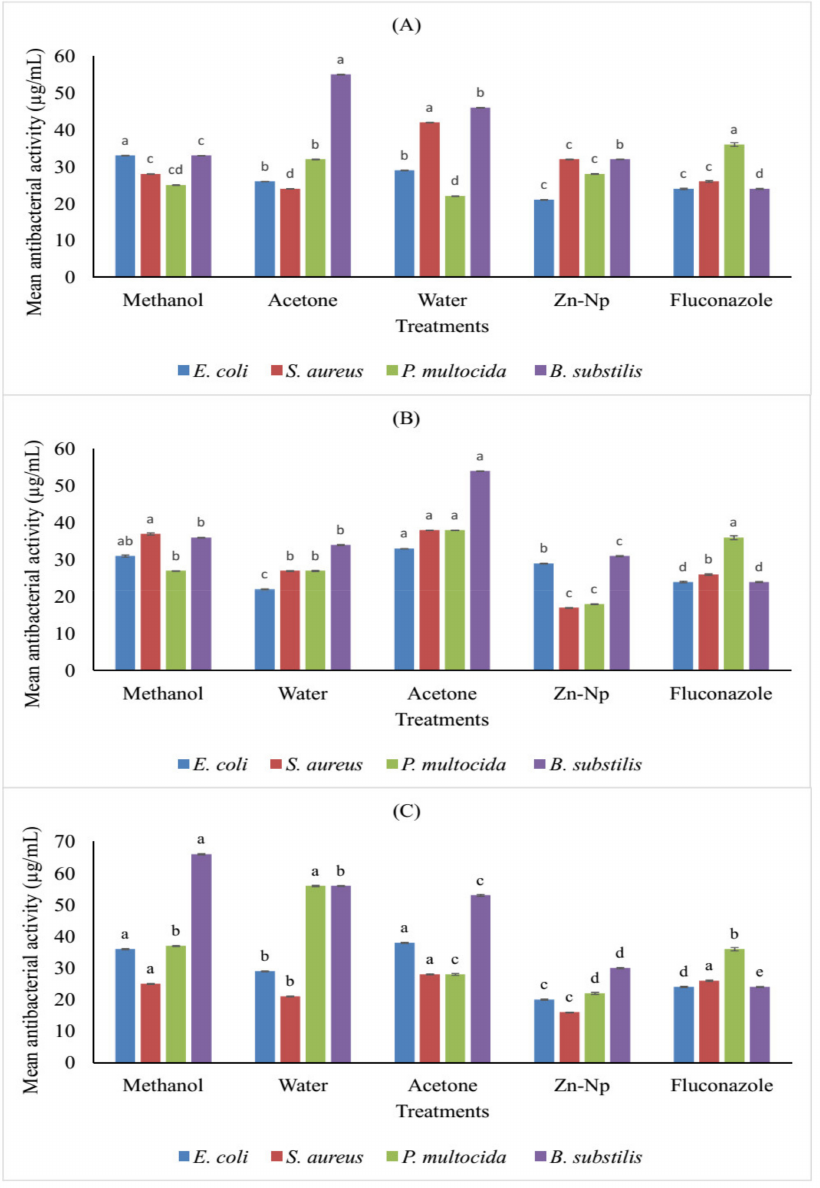
Figure 8. Comparison (MICs) in ( µ g/mL) different concentrations offlower ( A ), leaf ( B ), and stem ( C ) extracts of C. gigantea along with nanoparticles against selected bacterial strains. Bars with different letters are significantly different from each other at p =